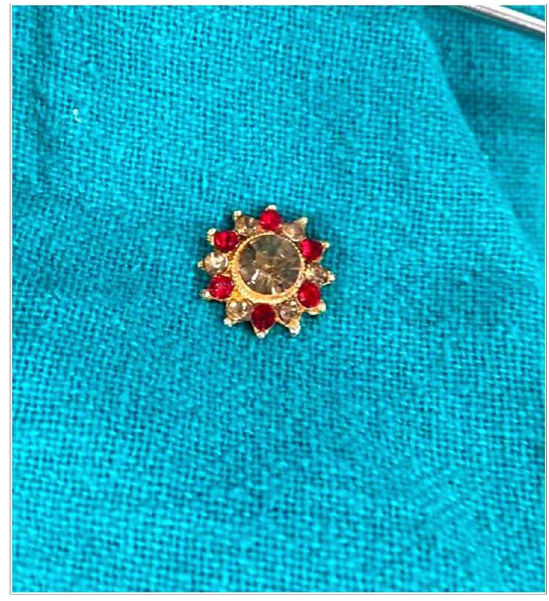
Fig. 2 The earring diameter — 2 cm